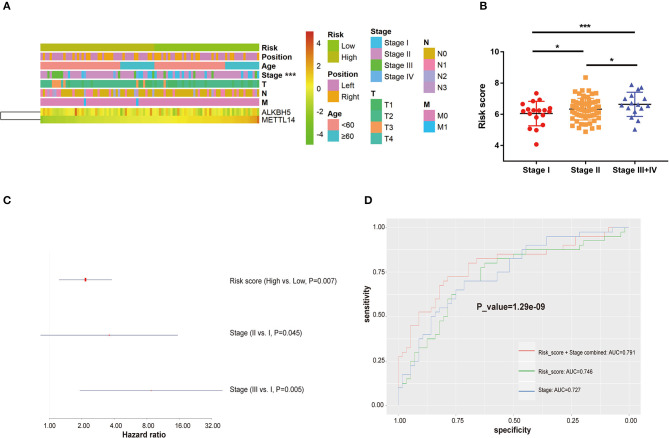
The relation between risk score and clinicopathological characteristics in TNBC. (A) The heatmap of risk distribution in TNBC patients with varied clinicopathological characteristics. (B) The comparison of risk score among patients with different TNM stages (Stage I+II vs. Stage III+IV). (C) Multivariate Cox regression analysis of the association between clinicopathological factors (risk score and stage) and overall survival of patients. (D) ROC curves comparing predictive sensitivity and specificity between the risk score and stage system. ROC: receiver operating characteristic. AUC, area under the curve. *P < 0.05, ***P < 0.001.